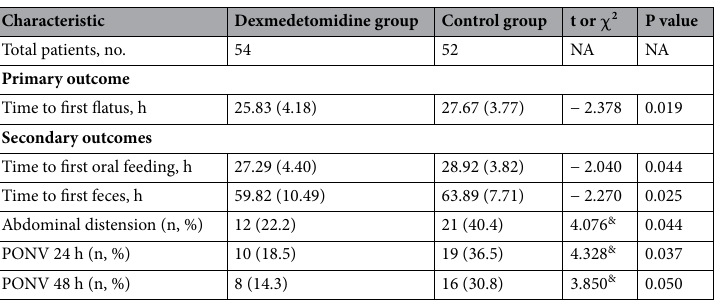
Table 2. Clinical postoperative outcomes. NA not applicable, PONV postoperative nausea, and vomiting, NRS numeric rating scale, h hour, n number. & χ 2 value.